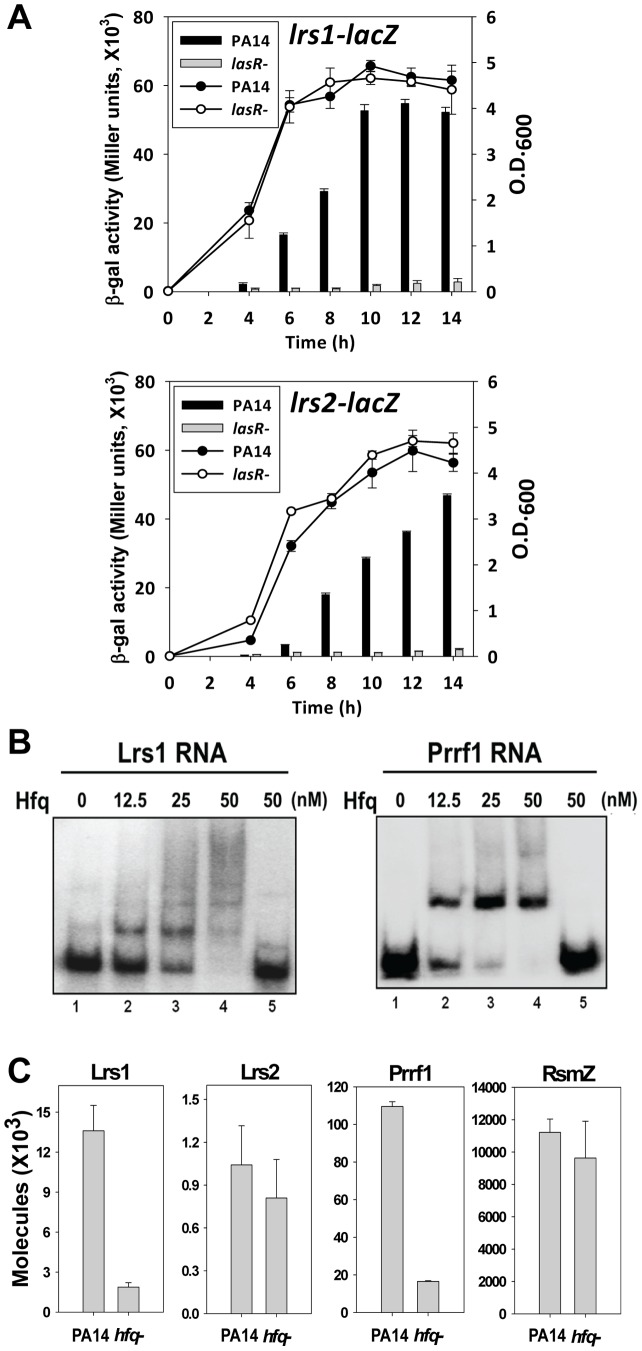
Characterization of the LasR-regulated small RNAs Lrs1 and Lrs2.(A) Growth (lines) and expression of the lrs1 or lrs2 reporter constructs (bars) in wild-type or ΔlasR P. aeruginosa PA14 are shown. (B) Role of Hfq in controlling the levels of Lrs1 and Lrs2 sRNAs. Gel shift analyses of sRNAs interaction with increasing amounts of purified Hfq are shown. Lane 5 in both panels contains, in addition to labeled probe, a 100-fold excess of unlabeled Lrs1 or Prrf1 RNA. (C) Lower panels show RT-PCR analyses of Lrs1 and Lrs2 expression in P. aeruginosa wild-type and Δhfq. Prrf1 and RsmZ were used as positive and negative controls, respectively, for sRNAs interacting and not interacting with Hfq.